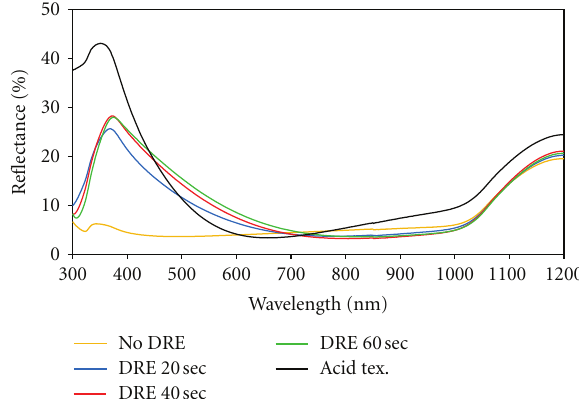
Figure 5: After antireflective coating, reflectance of acidic- and RIE- textured surfaces with various DRE